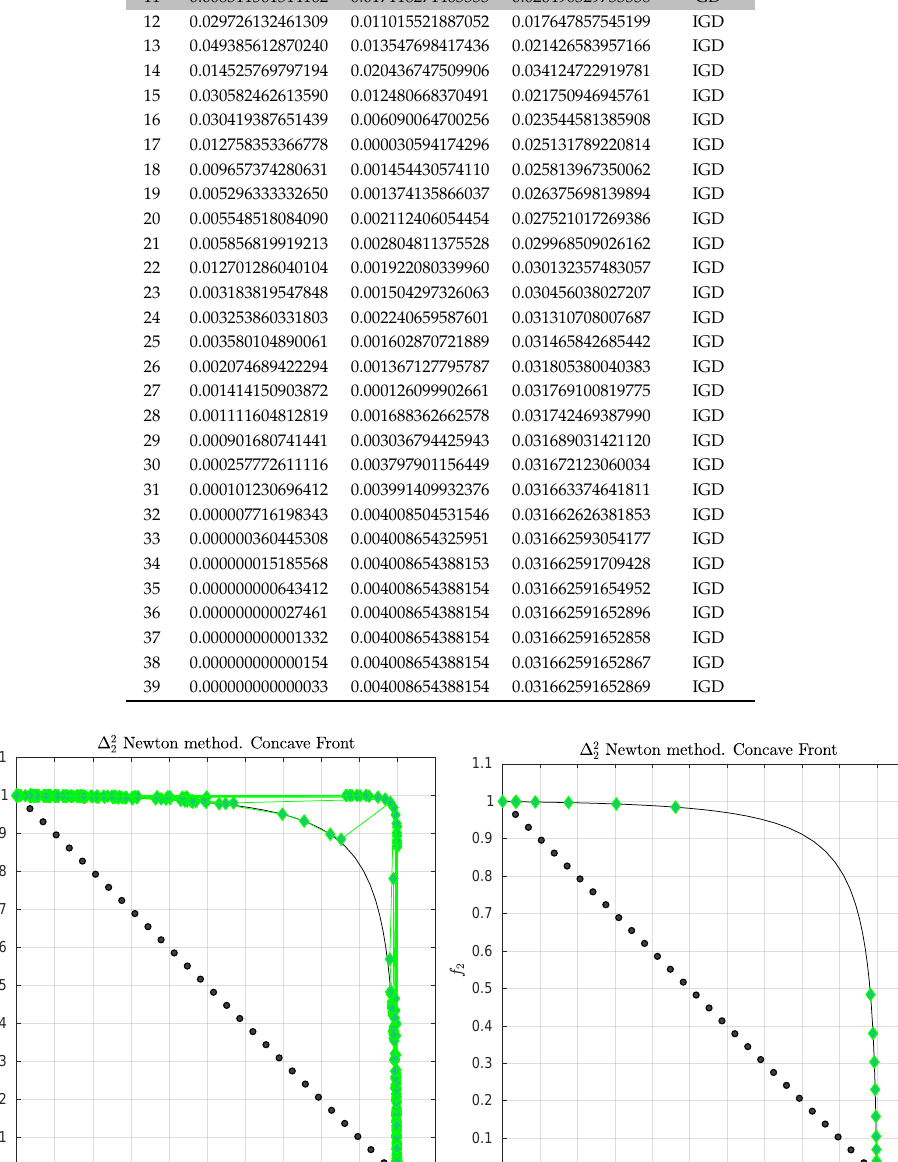
-Newton method on BOP (50). ( Right ) the final 2